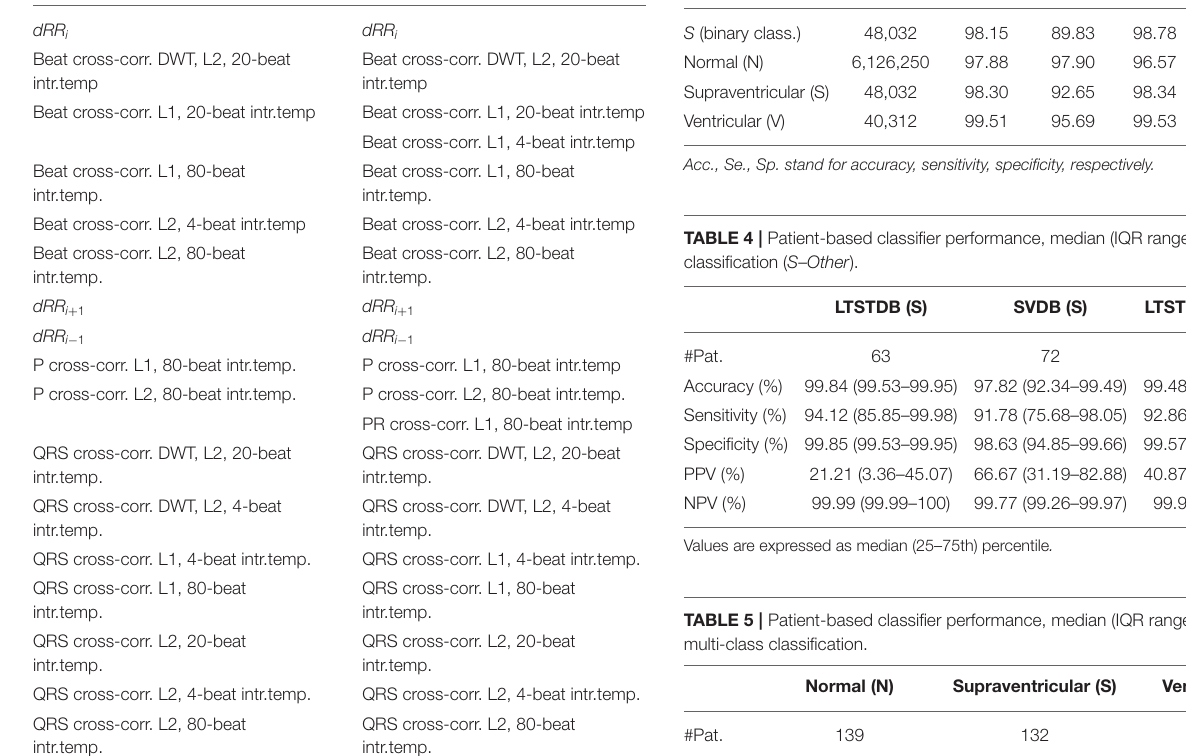
TABLE 2 | The ten most relevant features for each cross-validation KFold for the bi-label and the multi-label classification. Bi-label classification Multi-label classification